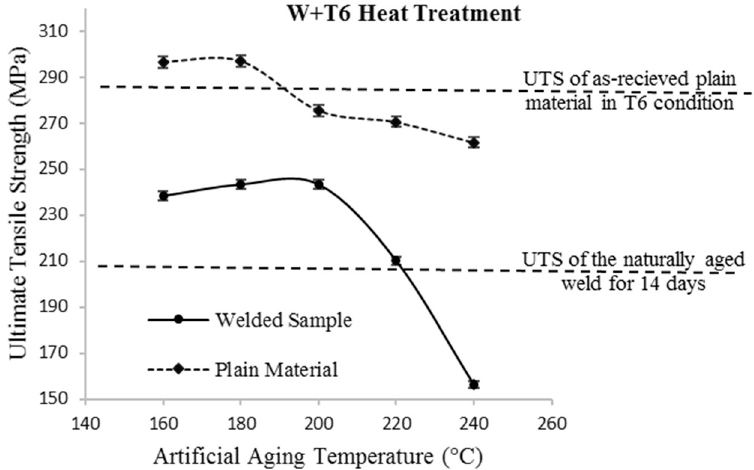
Figure 11. The effect of a solubilizing heat treatment followed by artificial aging at different temperatures (at optimized durations obtained from the previous section) on the tensile properties of the welded samples and plain material.